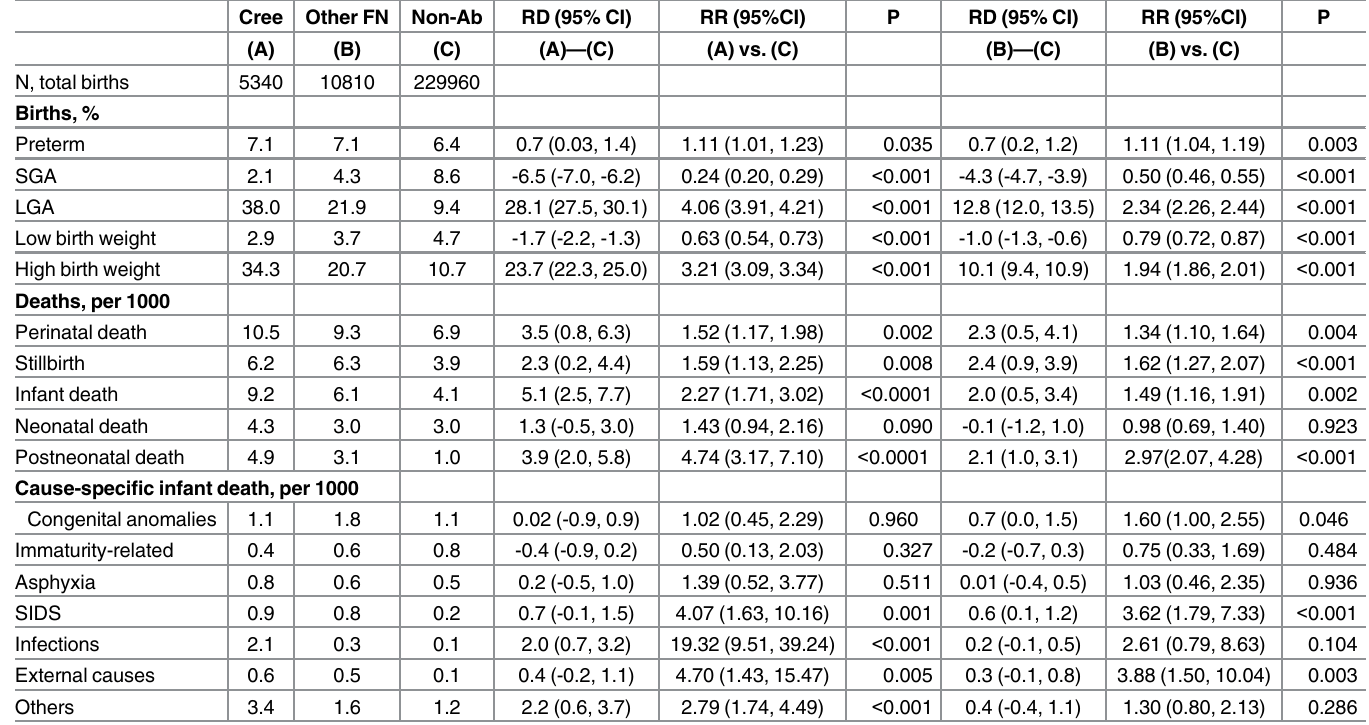
Table 2. Birth outcomes, perinatal and infant mortality in Cree, other First Nations and non-Aboriginal communities, Quebec 1996 – 2010. Cree Other FN